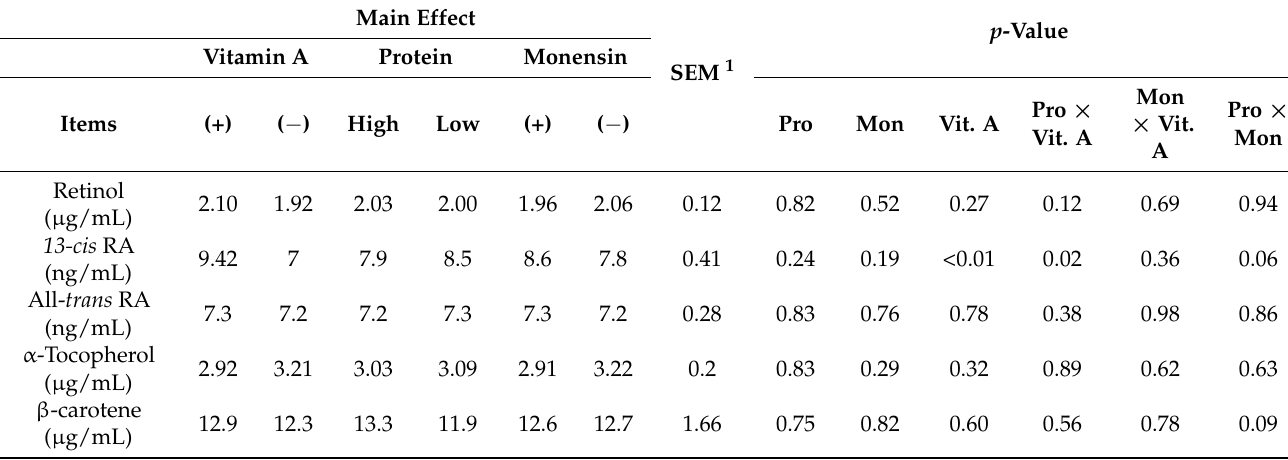
Table 6. Serum concentration for various retinoids, α -Tocopherol, and β -carotene of multiparous Holstein dairy cows ( n = 80, total) that were fed diets with crude protein levels (10.3%, n = 40 vs. 12.2% dry matter basis, n = 40), and within each crude protein group fed monensin (400 mg/day per head or none) and vitamin A (110 IU/kg body weight or none)